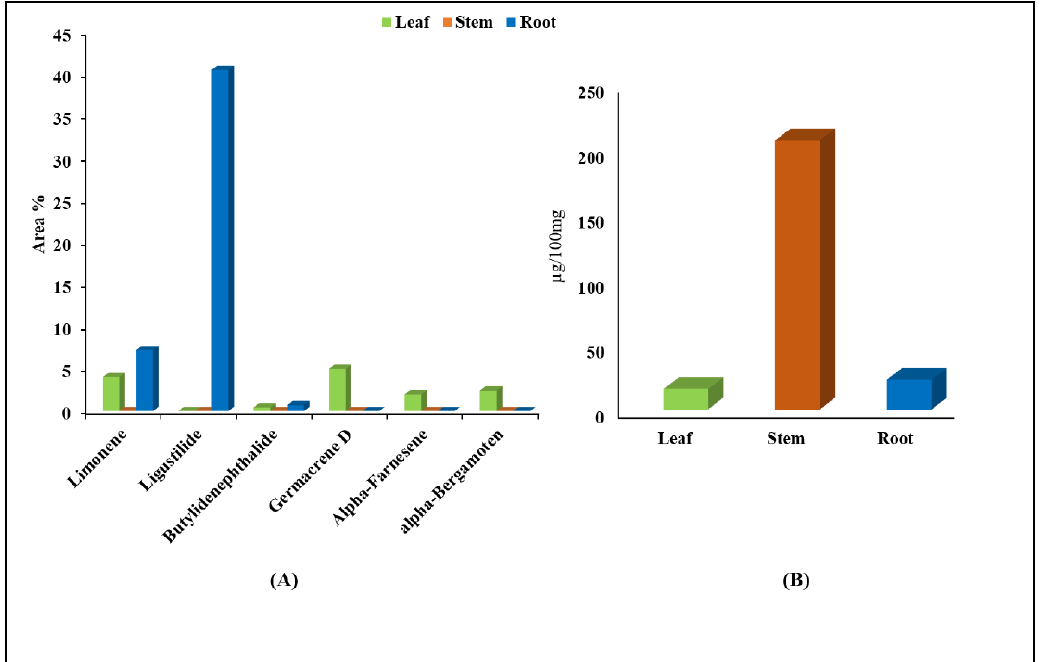
Figure 11. ( A ) GC ‐ MS analysis of bioactive metabolites and ( B ) UPLC analysis of ferulic acid in leaf, stem, and root tissues of A. glauca.